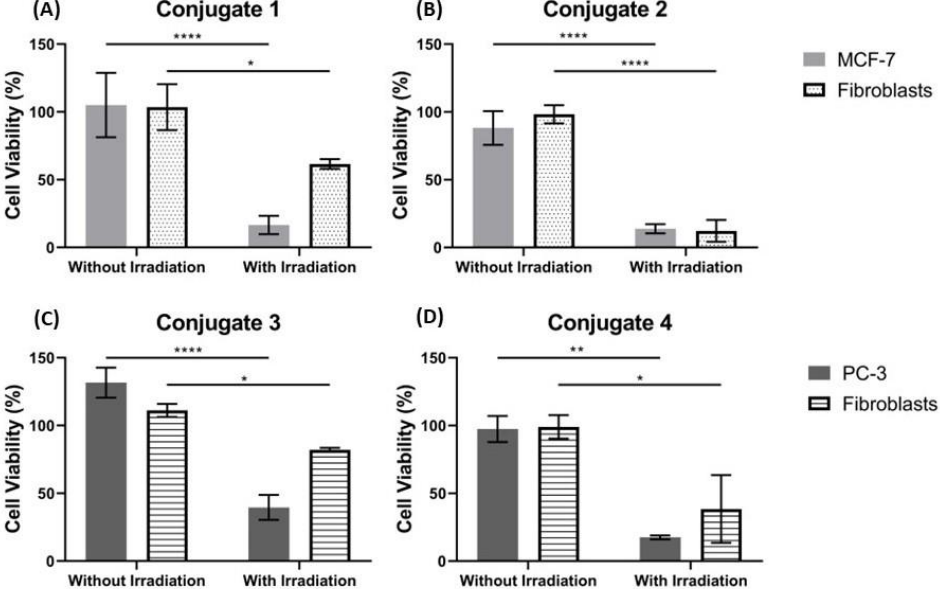
Figure 10. Viability of breast cancer cells MCF-7 and normal dermal fibroblasts following estradiol- BODIPY treatment and visible light irradiation: ( A ) E2-BODIPY conjugate 1 and ( B ) 11 β -OMeE2- BODIPY conjugate 2 . Viability of prostate cancer cells and normal dermal fibroblasts after andro- gen-BODIPY treatment and visible light irradiation: ( C ) 9-nortestosterone-BODIPY conjugate 3 and ( D ) 7 α -Me-9-nortestosterone-BODIPY conjugate 4 . Cell viability was assessed with MTS assay in MCF-7 and PC-3 cell lines and fibroblasts 24 h after visible light irradiation. Data are normalized against the control (0.25% v / v DMSO) and expressed as the mean ± SEM of two independent assays. The statistical significance was evaluated by the two-way ANOVA method (* p ≤ 0.05; ** p ≤ 0.01; **** p ≤ 0 .0001).